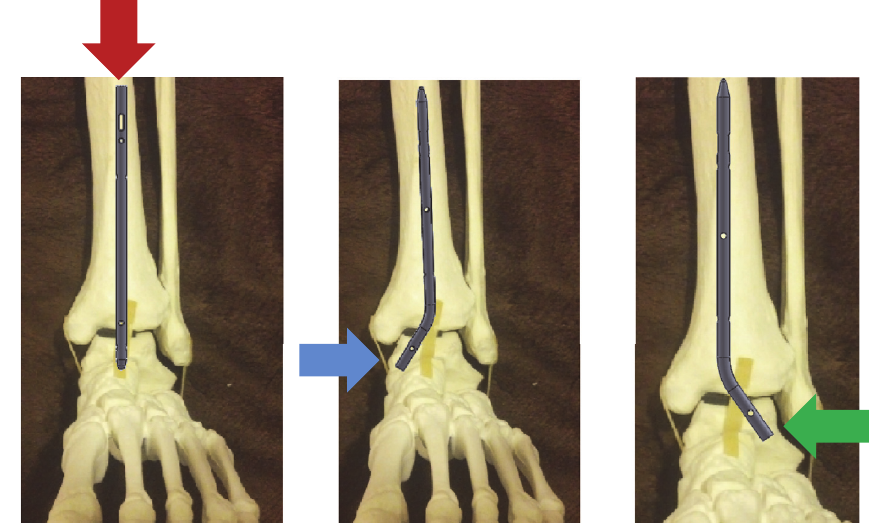
Figure 1: Insertion